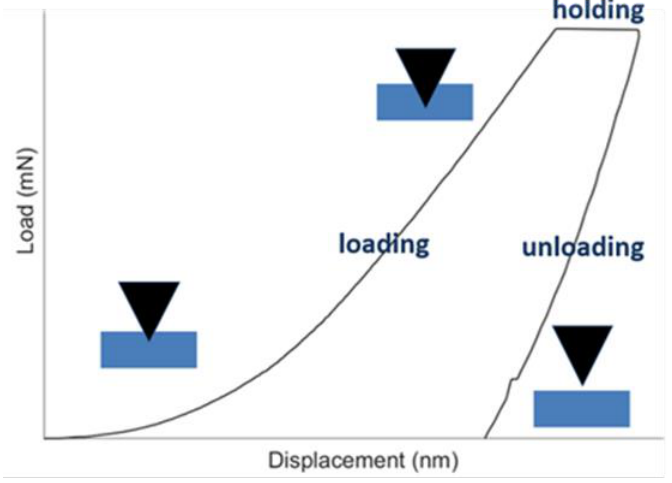
Figure 4. Explanatory curve of the indentation process. The discontinuities in the last part of the unloading phase is characteristics of the thermal drift measurement process.